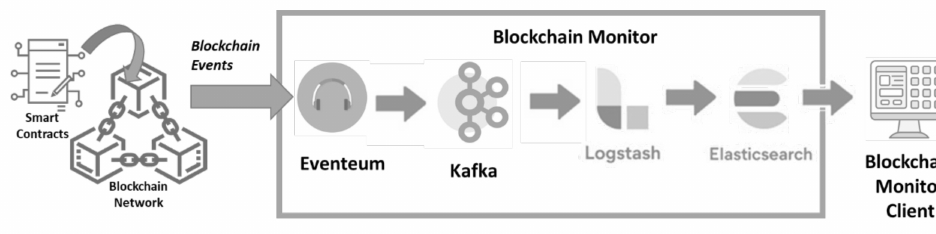
Figure 3. Blockchain monitor